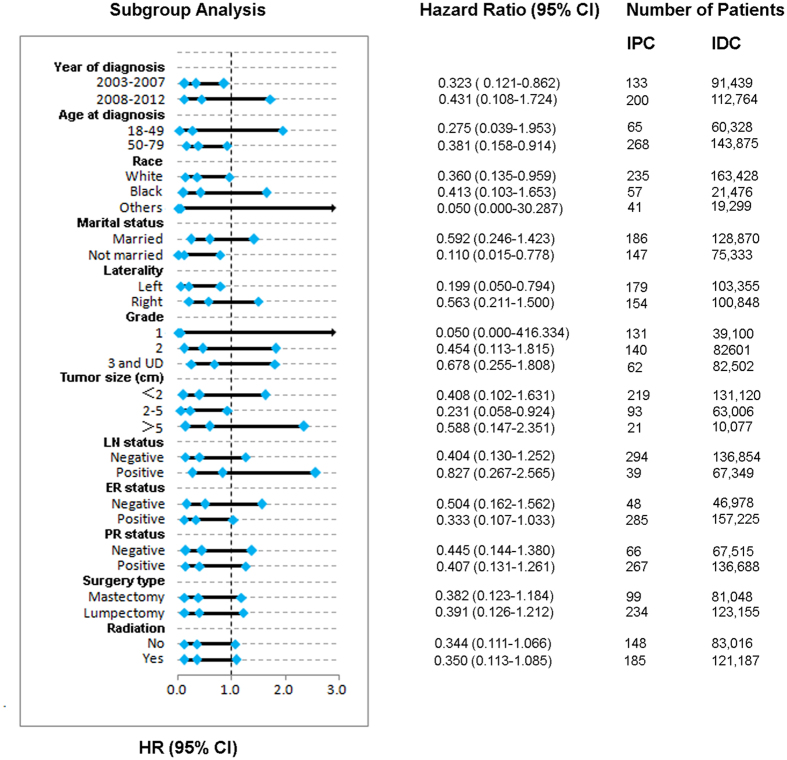
Forest plot of hazard ratios (HRs) for invasive papillary carcinoma (IPC) versus infiltrating ductal carcinoma (IDC) in the subgroup analysis.The diamond on the X-axis indicates the HR and the 95% confident interval (CI) of each subgroup.